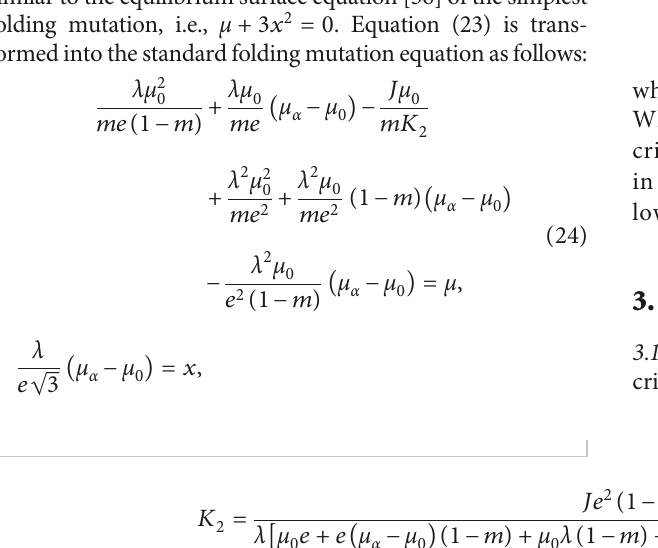
Figure 3: Schematic diagram of folding catastrophe